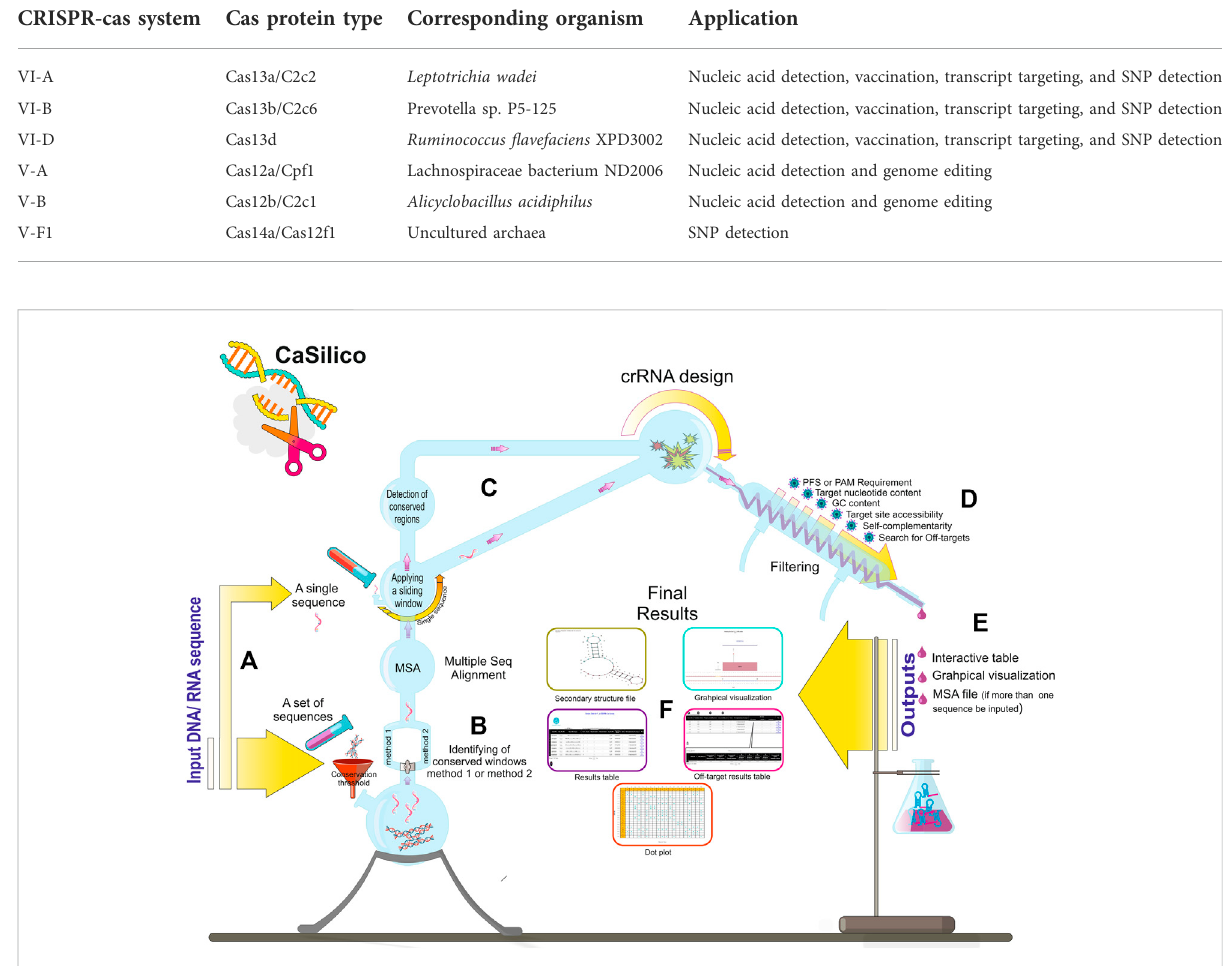
FIGURE 1 CaSilico work fl ow. (A) CaSilico accepts asingle or a setof DNAor RNA sequences to bescanned for crRNA designing. (B) When more than one sequence is given as input, the conserved regions among them are automatically detected considering conservation threshold and one of the two different approaches for identifying conserved regions. (C) A sliding window (stride of 1 nt) is employed across the single sequences or conserved region of multiple sequences to specify potential target sites. (D) CaSilico applies multiple criteria for crRNA designing, performs off-target analysis, and returns outputs in an interactive graphical interface and some fi les such as MSA and secondary structure (E,F)